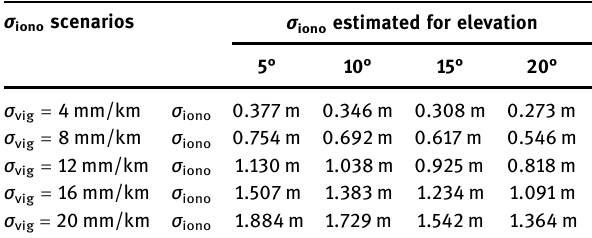
Table 2: σ iono calculated for all σ vig scenarios evaluated σ iono scenarios